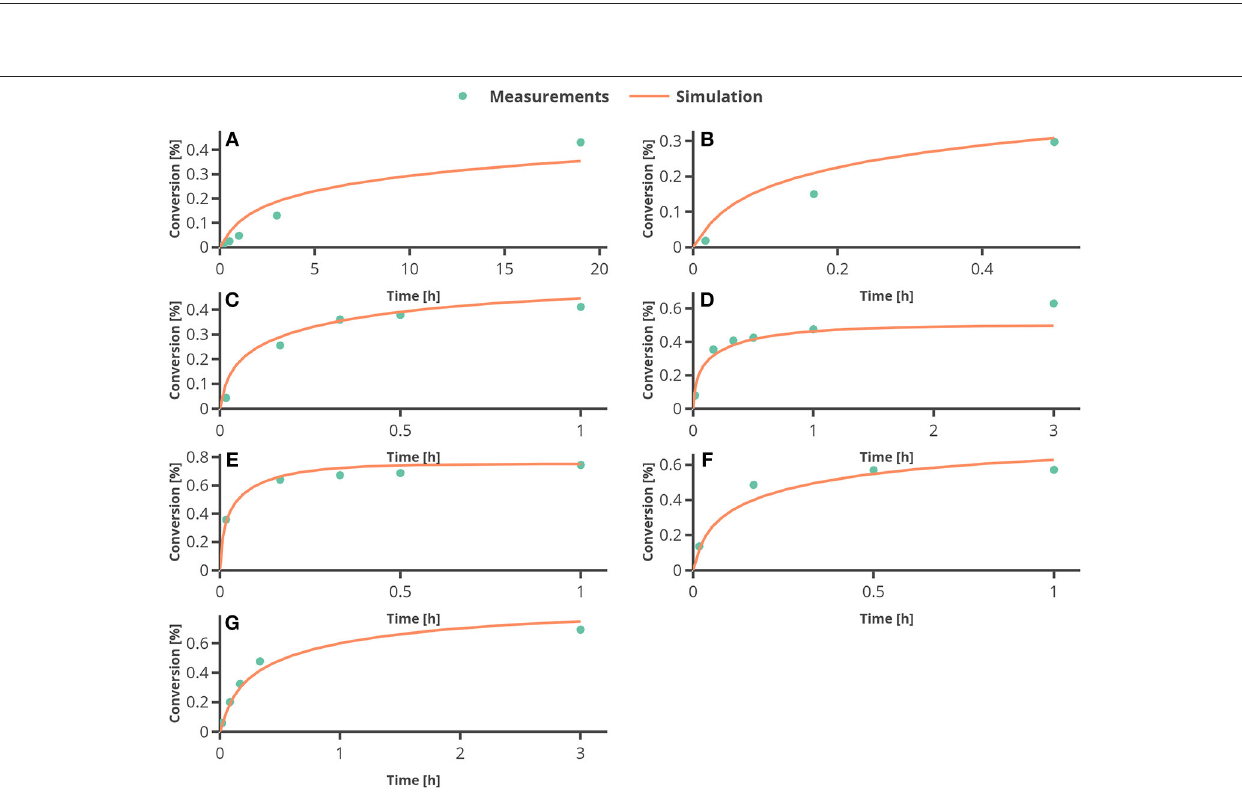
Frontiers in Bioengineering and Biotechnology | www.frontiersin.org